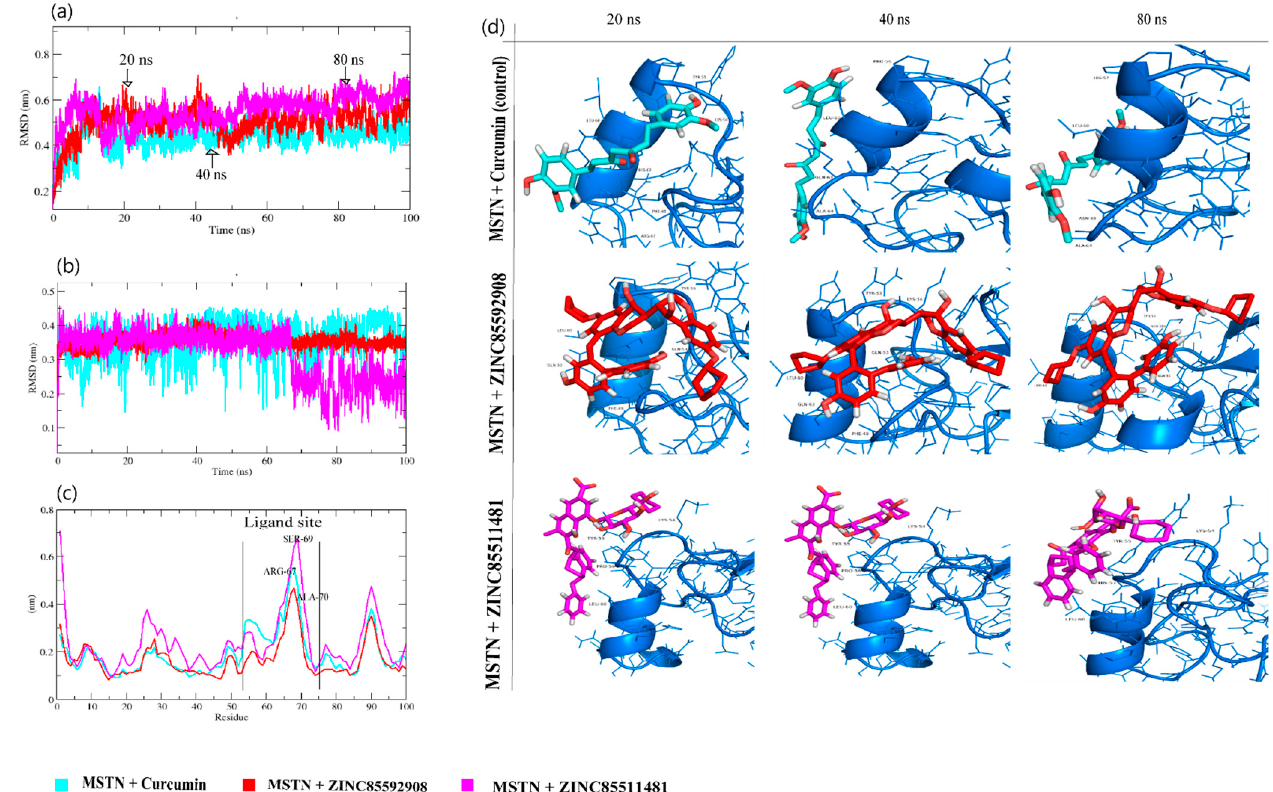
Figure 3. Conformational studies of complexes. ( a ) Root mean square deviation of backbone of MSTN protein, ( b ) Root mean square deviation of ligands, ( c ) Root mean square fluctuation of MSTN protein, ( d ) snapshots of complexes with different interval of time 20, 40 and 80 ns.